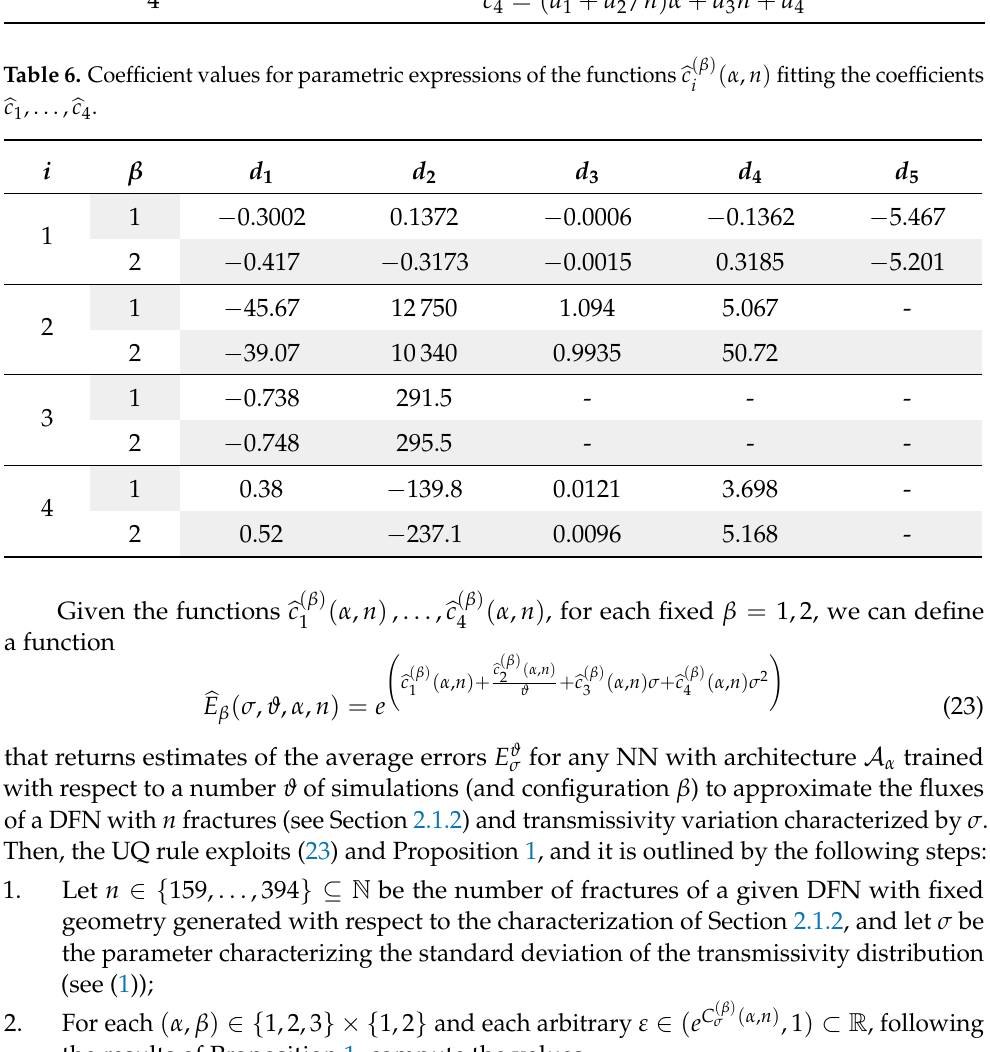
( β ) ( α , n ) fitting the coefficients i